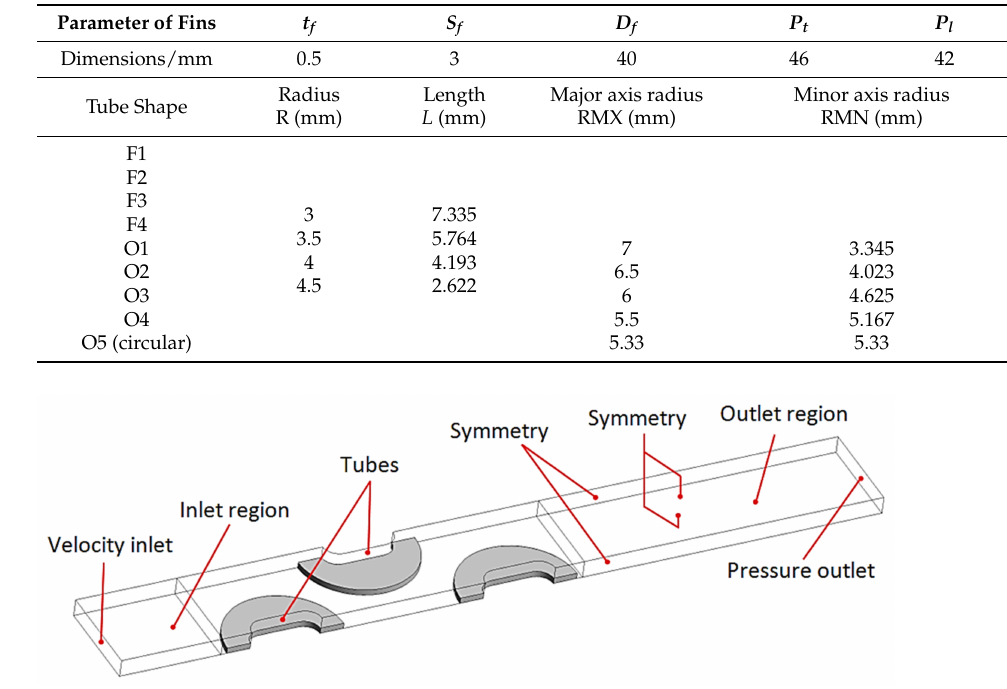
Figure 3. 3-D Computational